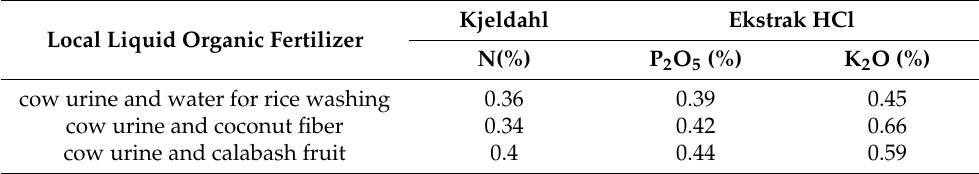
Table 2. Analysis of nutrient content of local liquid organic fertilizer.